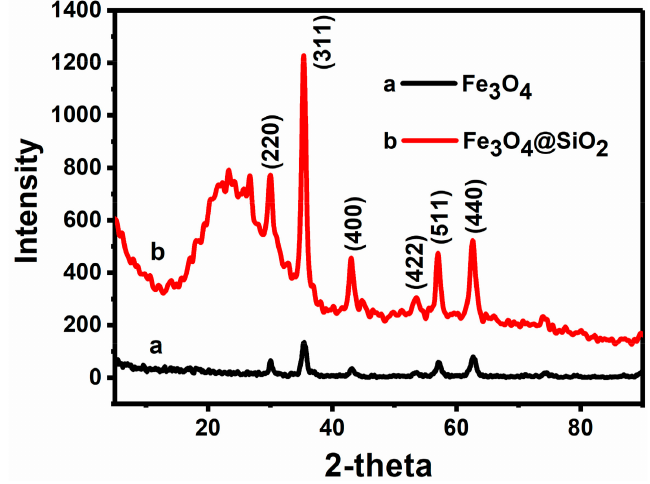
Figure 2. XRD of Fe 3 O 4 MNPs and Fe 3 O 4 /SiO 2